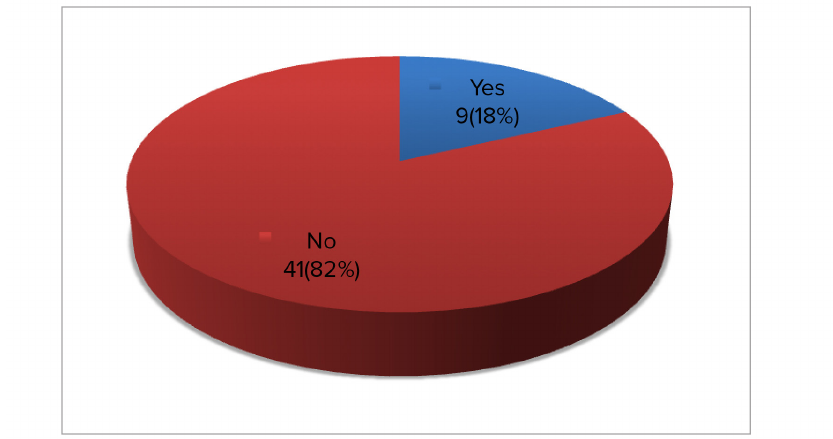
Figure 2: Distribution of Patients According to the Family History of vitiligo Disease.